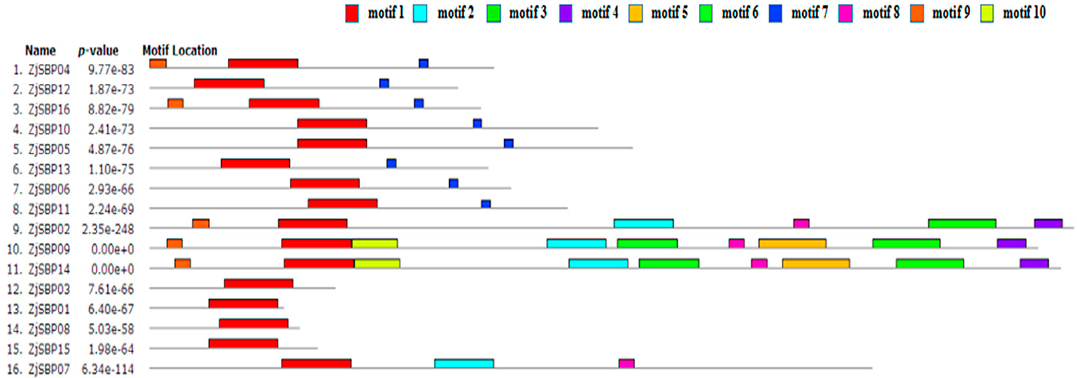
Figure 5. The motifs of each ZjSBP gene by MEME. Numbers 1–10 are displayed in different colored boxes. The sequence information for each motif is provided in Table 2. Table 2. Analysis and distribution of conserved motifs in ZjSBPs.